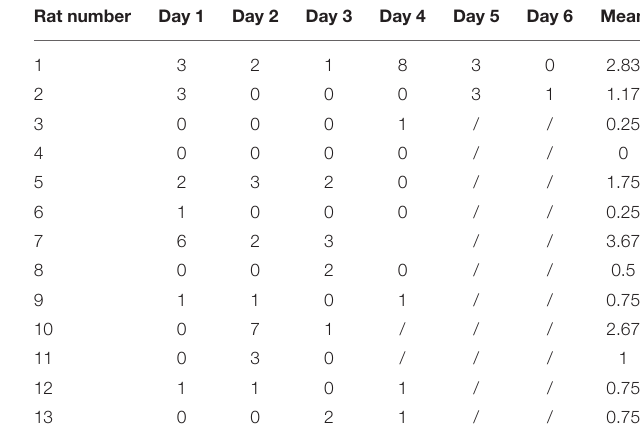
TABLE 2 | Number of epileptic attacks (Racine 2 or severer) during video